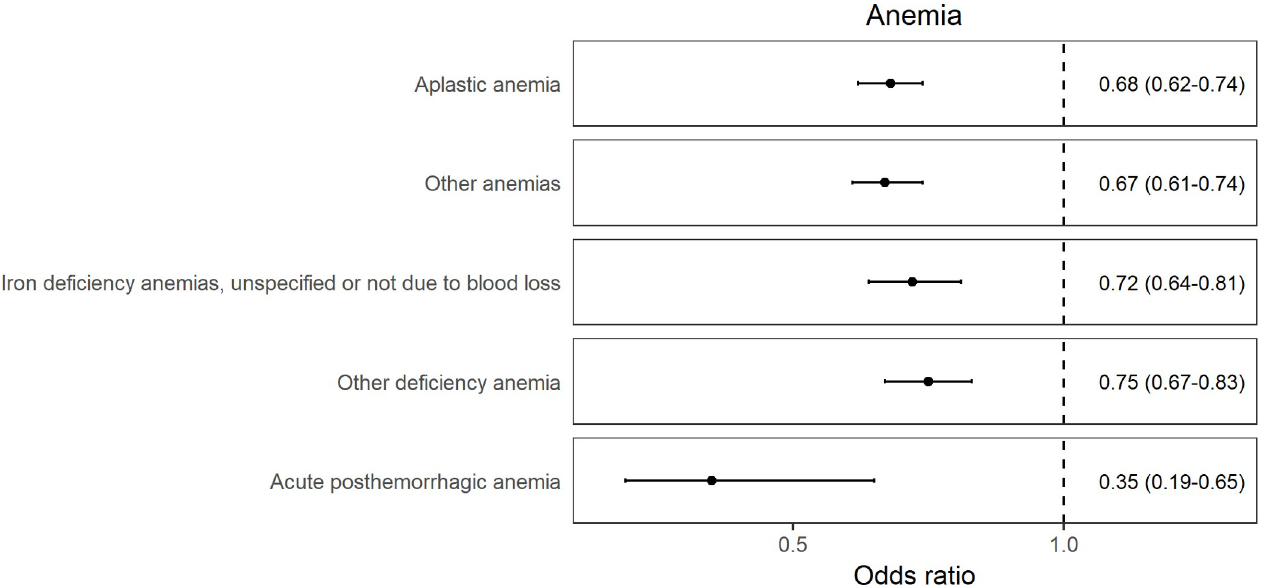
Fig 1. Forest plot of results for traits related to anemia for which there was evidence across the 3 genetic instruments for a causal effect of higher iron status. The ORs are reported as MR estimates corresponding to 1 SD increase in serum iron. MR, mendelian randomization; OR, odds ratio; SD, standard deviation.